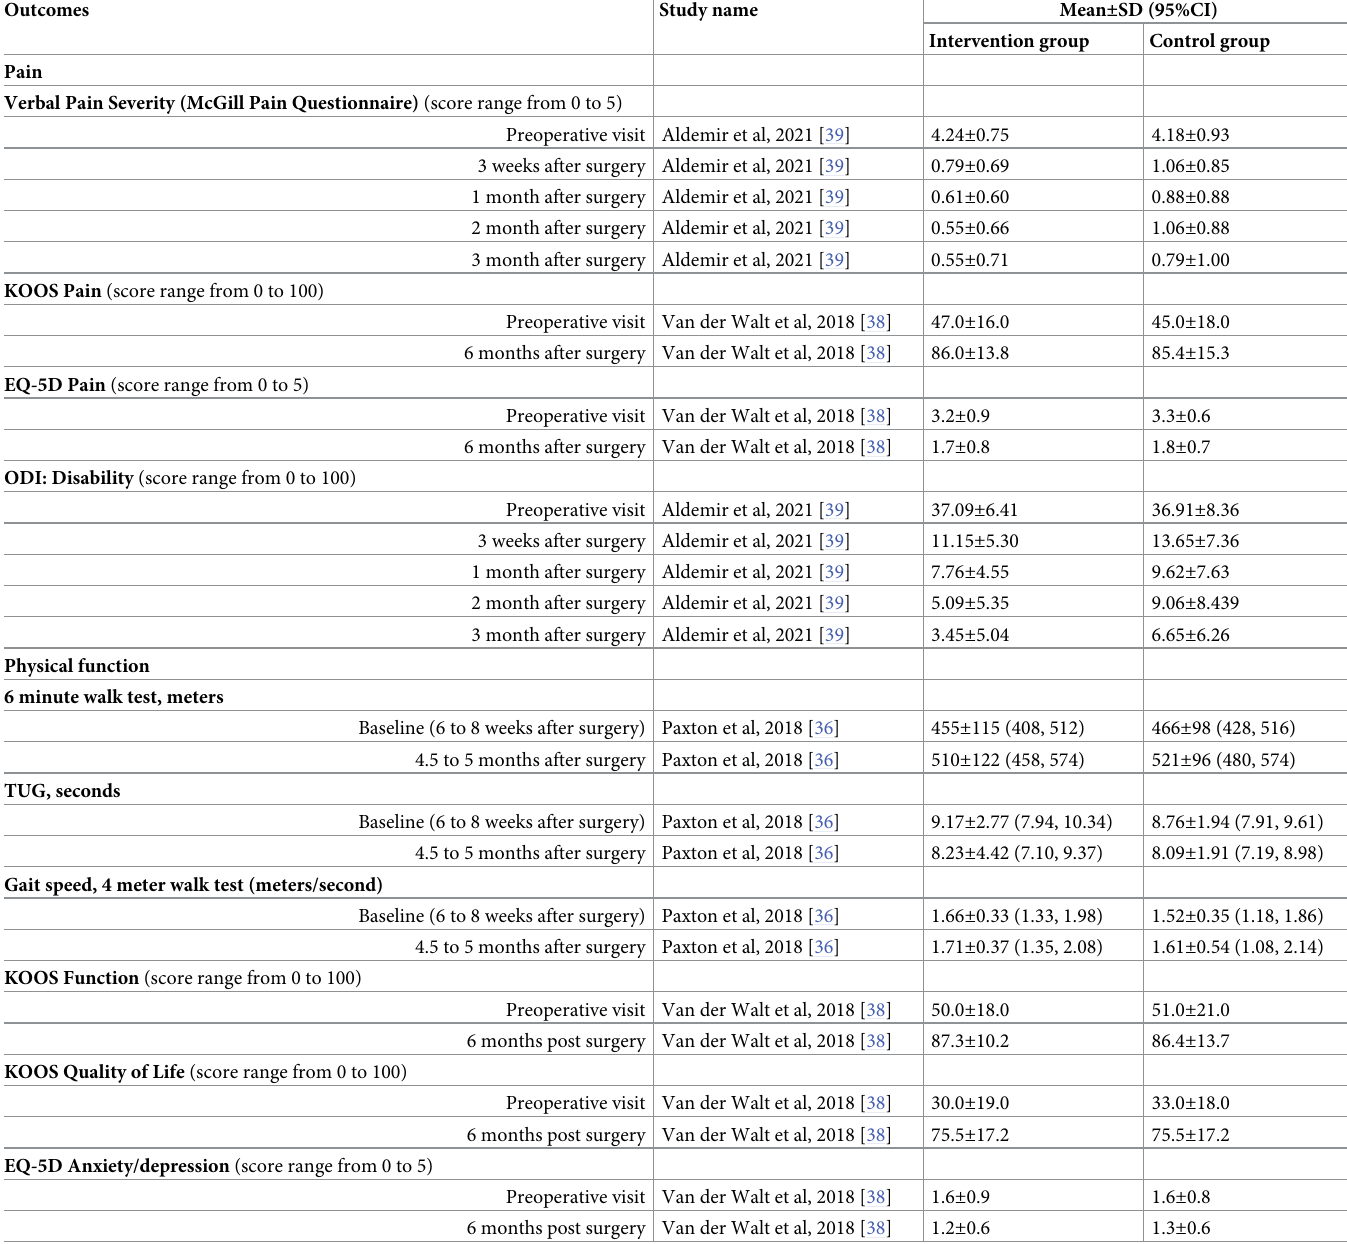
Table 4. Effects of physical activity interventions that use wearables on outcomes related to pain, physical function, general health and psychological distress in adults after orthopaedic surgery.